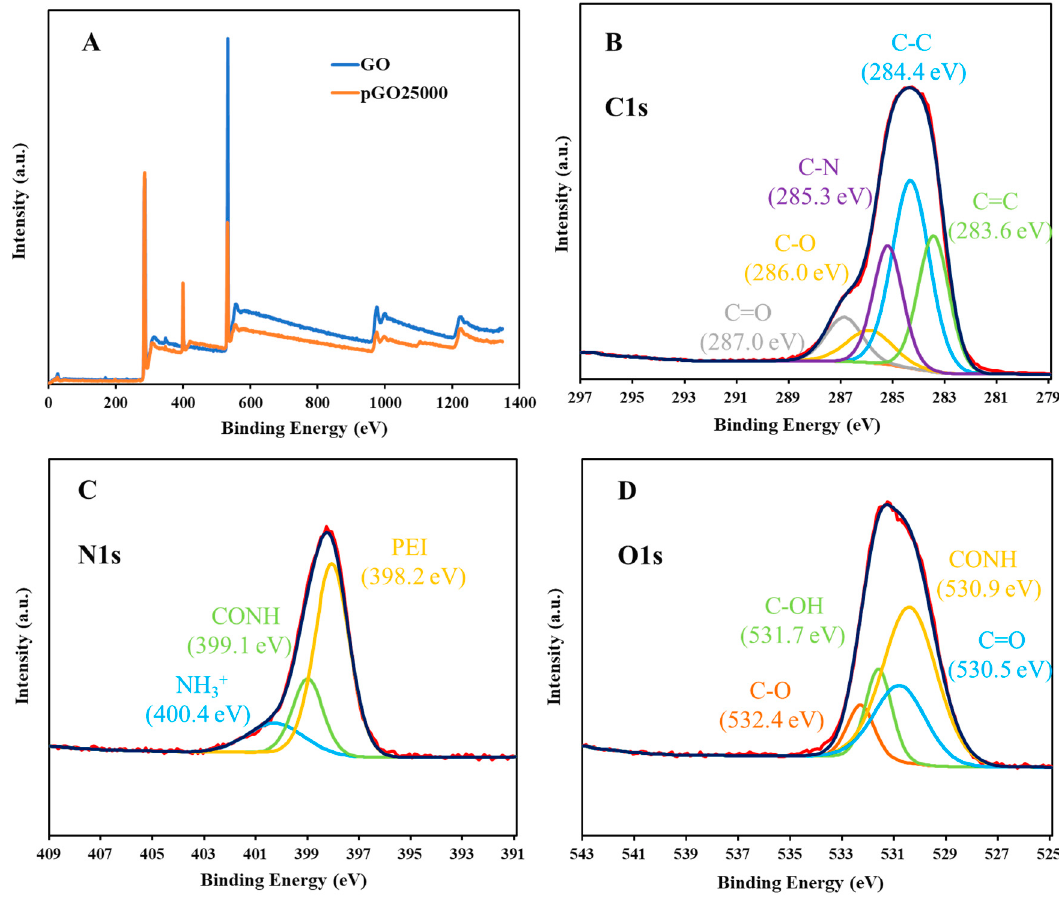
Figure 3. High-resolution XPS spectra of GO and pGO25000: ( A ) wide scan, ( B ) C1s spectrum of pGO25000, ( C ) N1s spectrum of pGO25000, and ( D ) O1s spectrum of pGO25000. pGO25000, ( C ) N1s spectrum of pGO25000, and ( D ) O1s spectrum of